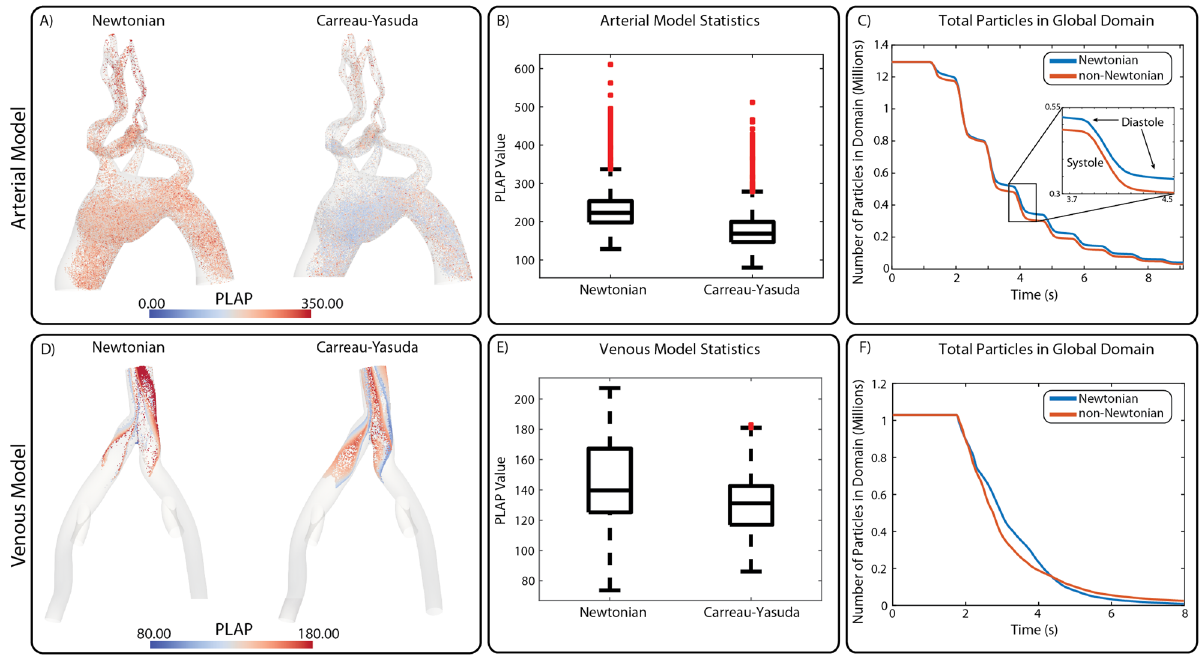
Figure 6. ( A , D ) Particles left in the arterial and venous computational domains for Newtonian and Carreau- Yasuda simulations. ( B , E ) Box and whisker plot describing the particles left in the domains. ( C , F ) Line plots describing the number of particles in the computational domains over